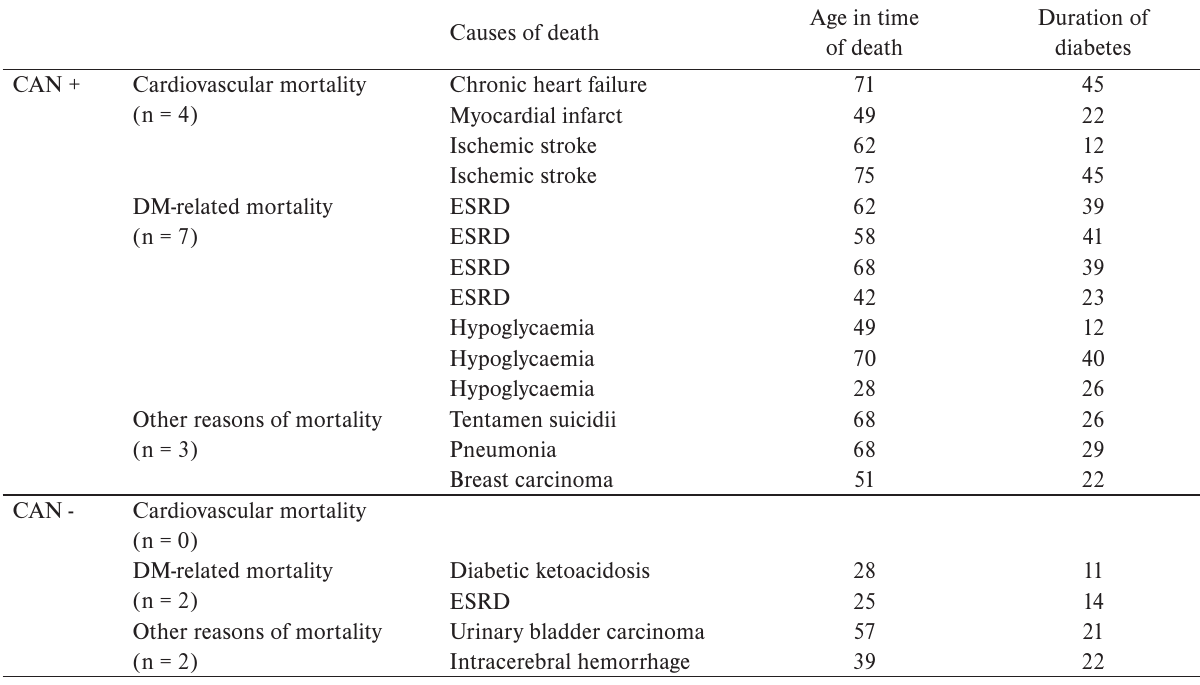
Table 5. Analysis of mortality in the group CAN+ and CAN- during 10 years follow up.